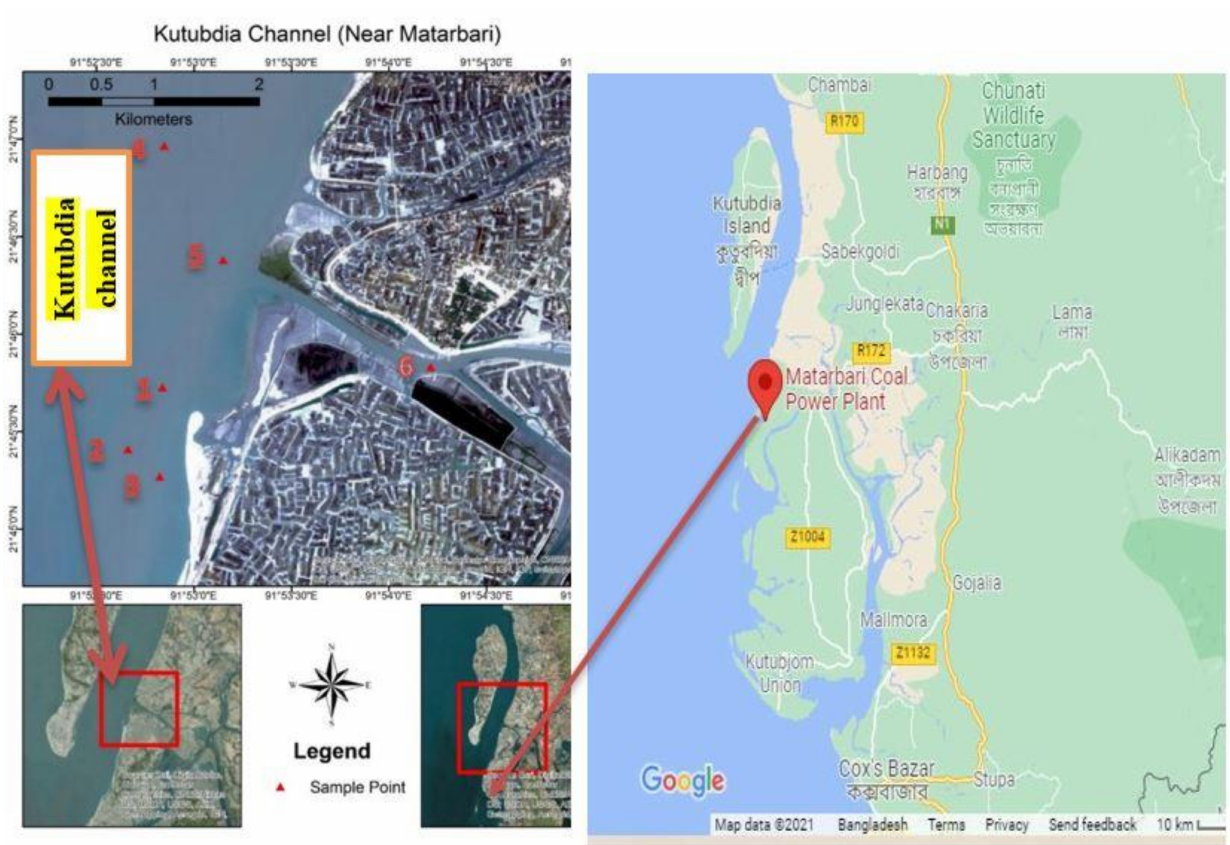
Figure 1. Sampling stations located in the Kutubdia Channel (near Matarbari), along the south-eastern Bay of